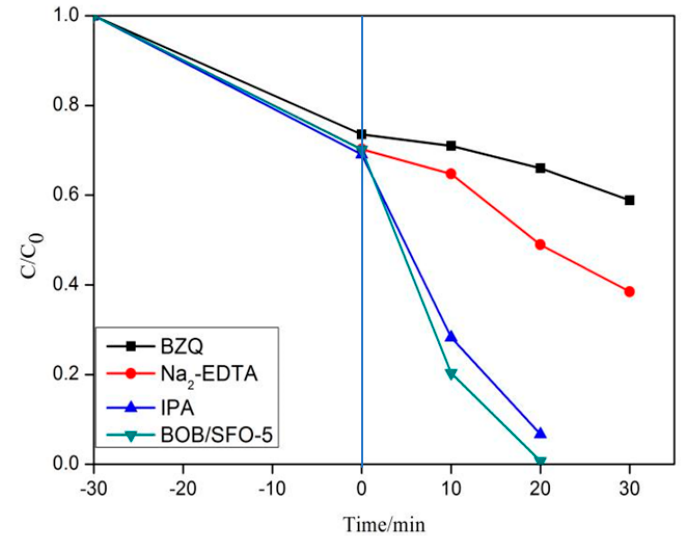
Figure 10. Degradation rates of RhB with BOB/SFO-5 in different hole-radical scavengers (1.0 mmol/L). BZQ—1,4-benzoquinone; Na 2 -EDTA—disodium ethylenediaminetetra acetic acid; IPA— isopropanol.